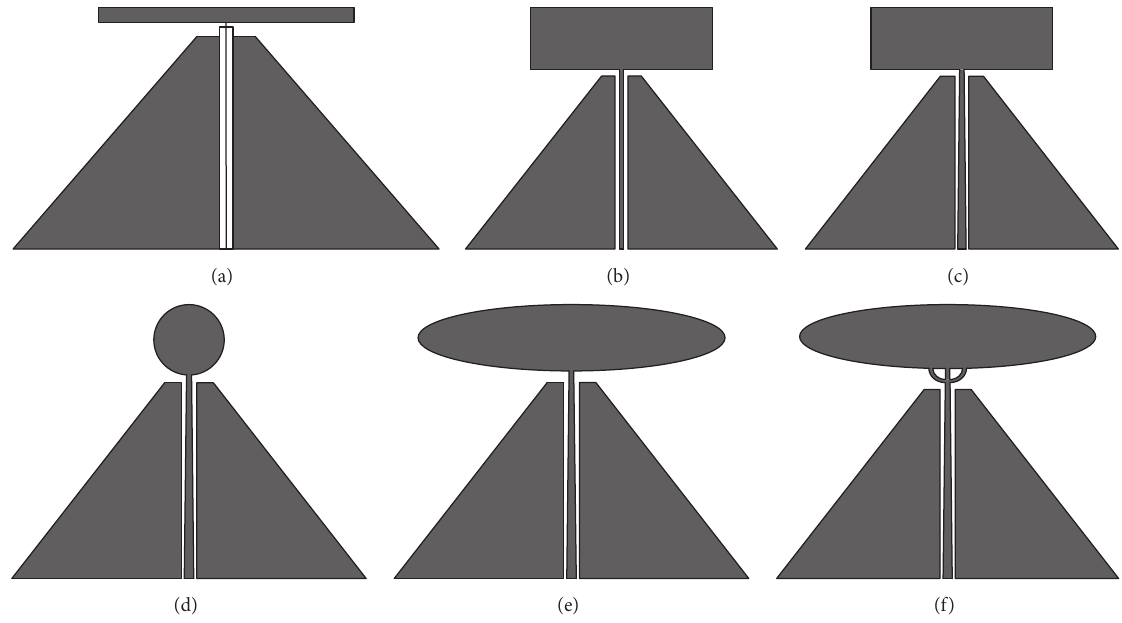
Figure 19: Printed antennas with trapeziform ground planes [74]. Different geometries of the monopole and of the excitation systems are shown in the figure.